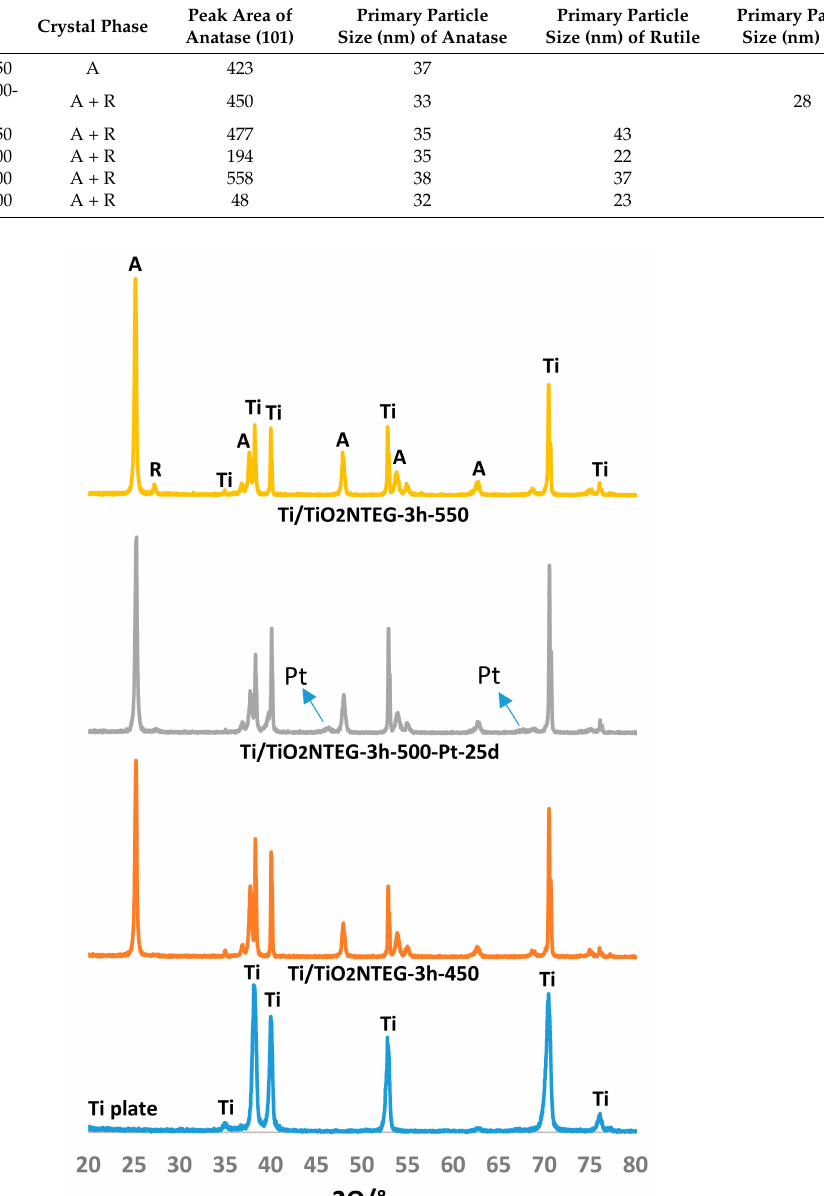
Figure 2. XRD patterns of the Ti/TiO 2 -NTEG-3h-Y